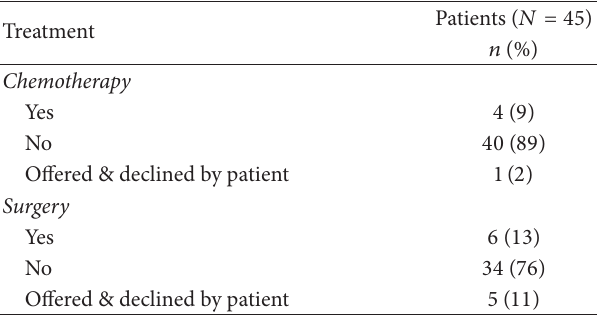
Table 3: Treatment details of all patients following repeat EUS- FNA for diagnosis of suspected pancreatic malignancy at St. Paul’s Hospital, Vancouver, British Columbia, between 2007 and 2014.